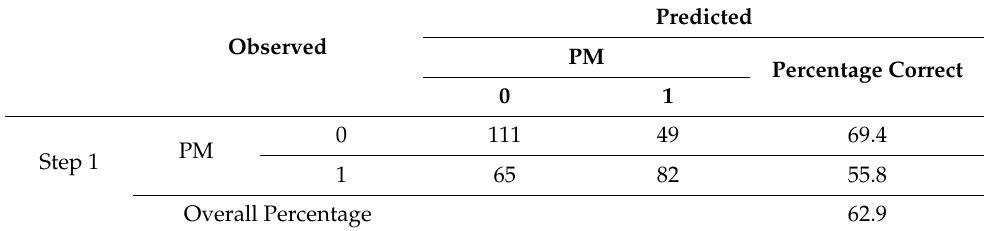
Table 15. Classification table a .